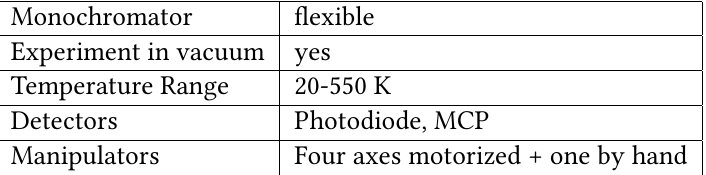
Table 1: Technical parameters of the Solid flexRIXS